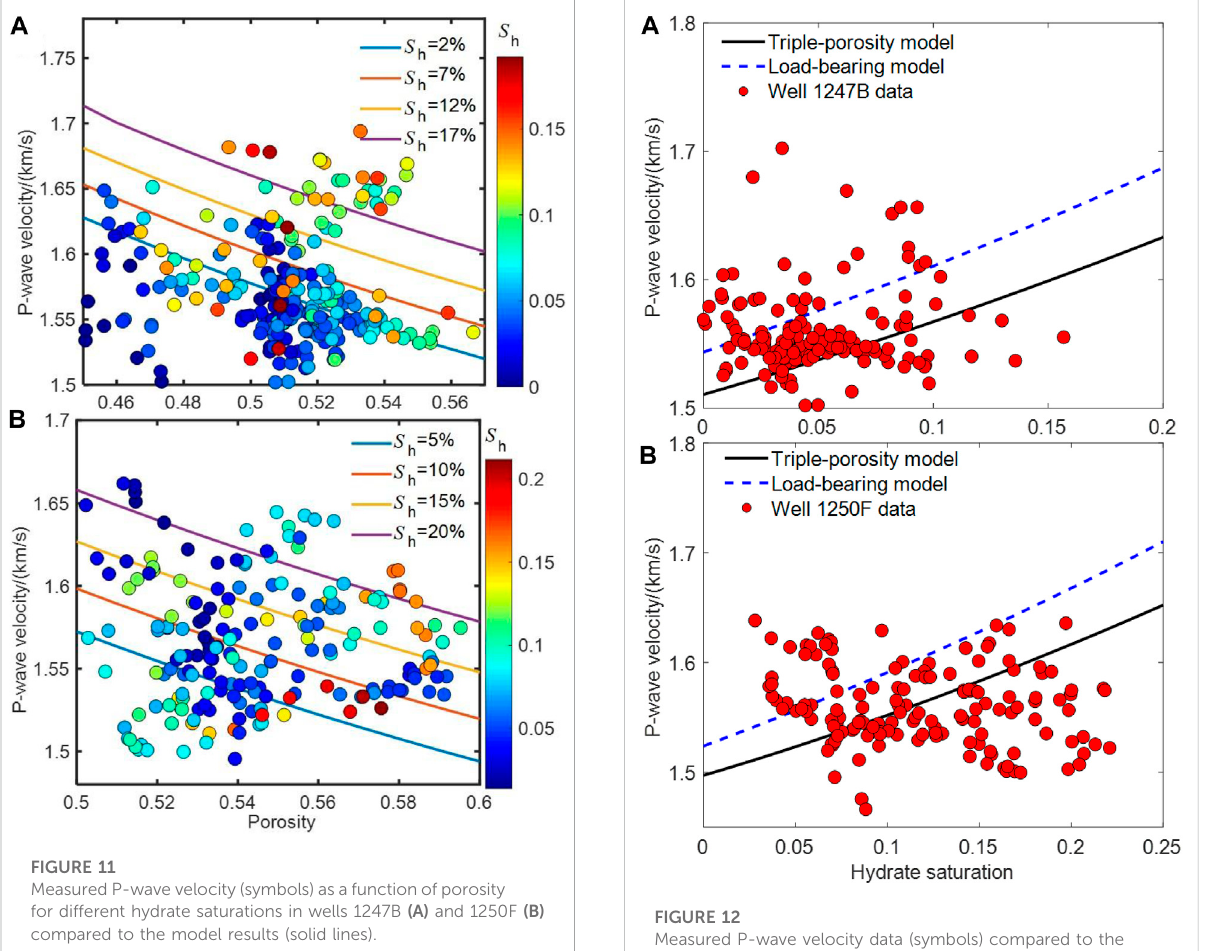
results ofthetriple-porosityand load-bearingmodels varyingwith hydrate saturation in Wells 1247B (A) and 1250F (B)